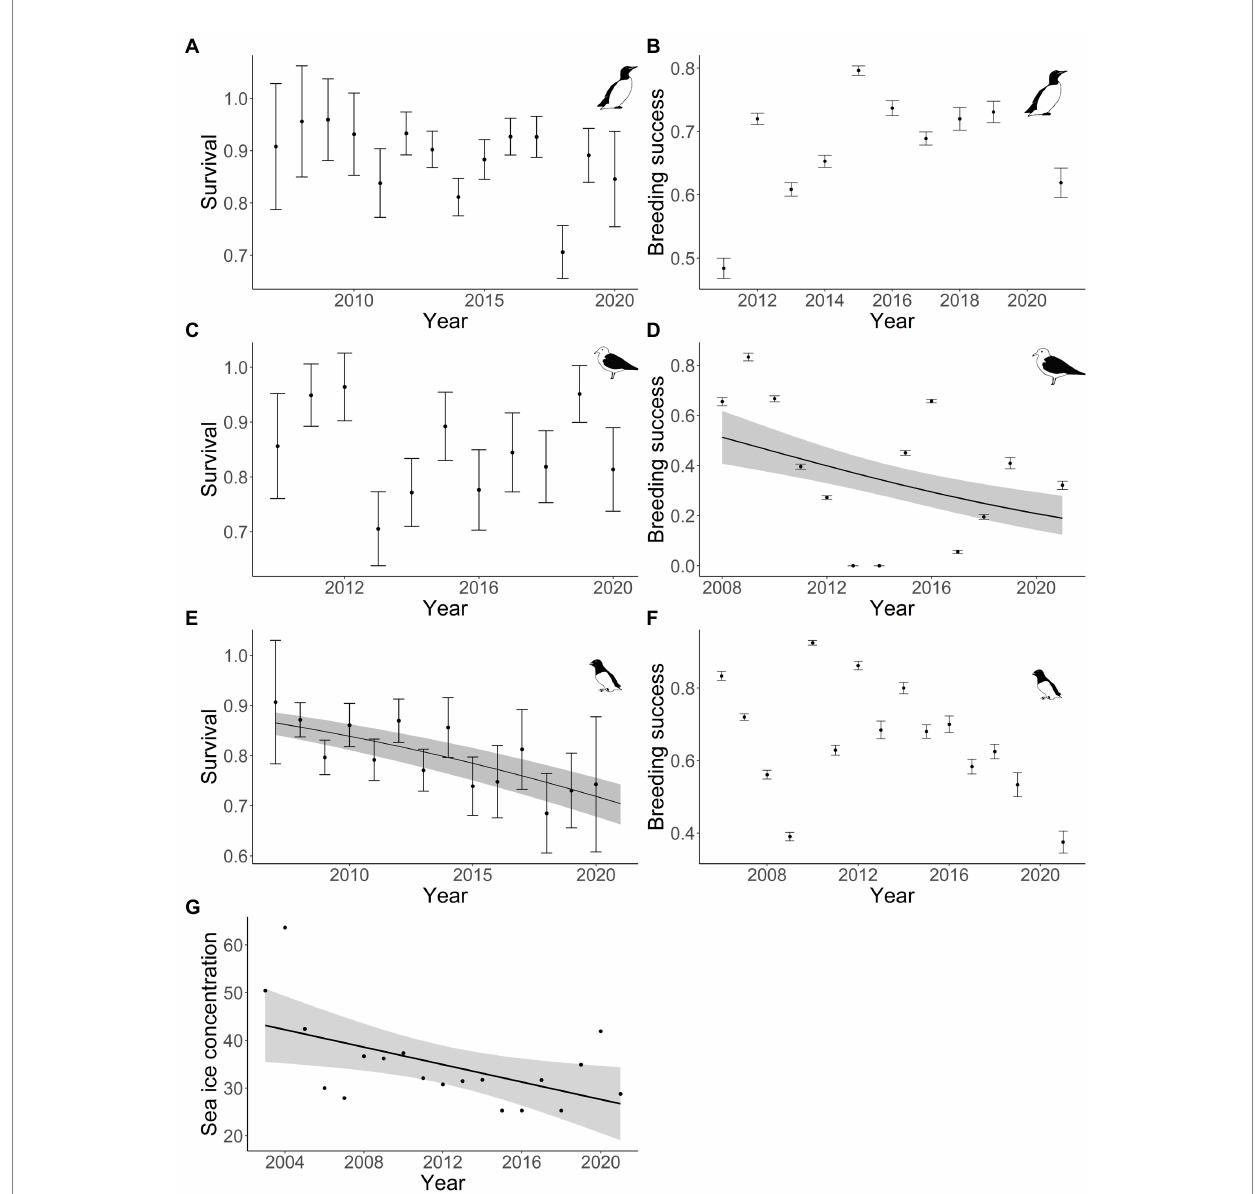
FIGURE 2 Long-term trends of demographic parameters of Brünnich guillemot (A,B) , black legged kittiwake (C,D) , little auk (E,F) and maximum sea-ice concentration (G) in West Spitsbergen (Svalbard archipelago, Norway). Survival was estimated from a time-dependent model with standard error. Plain line and shaded areas represent the estimated trajectory from the significant regression selected and its associated 95% confidence